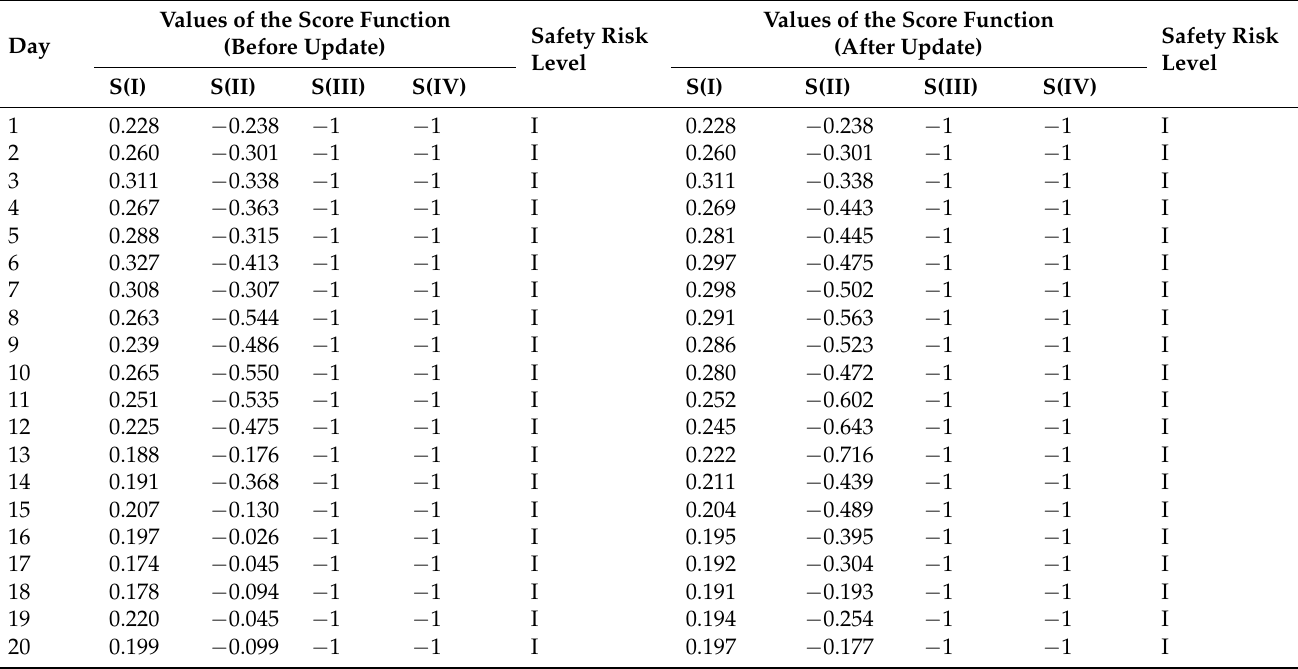
Table 11. Dynamic fusion results before and after